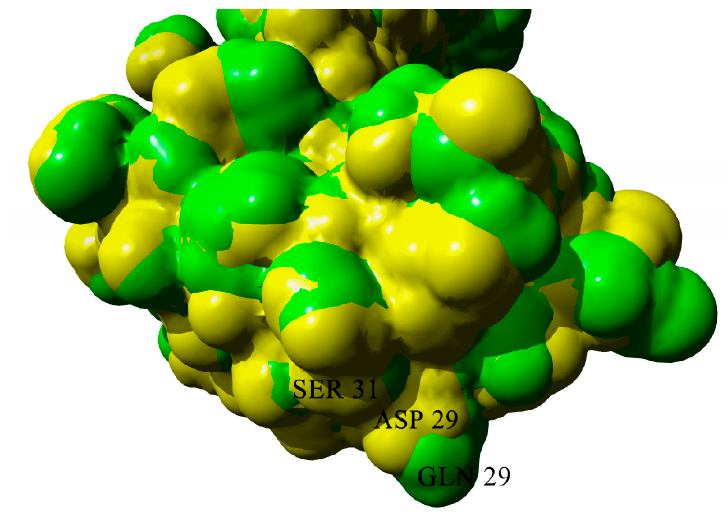
Figure 12. Solvent-accessible surfaces of wild-type BIF (yellow) and D29Q mutant (green).